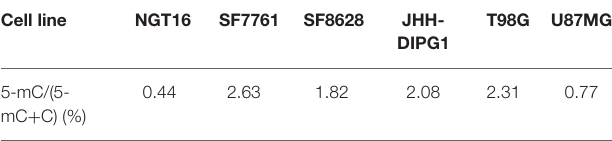
TABLE 2 | 5-methylcytosine (5-mC) levels of each cell line is